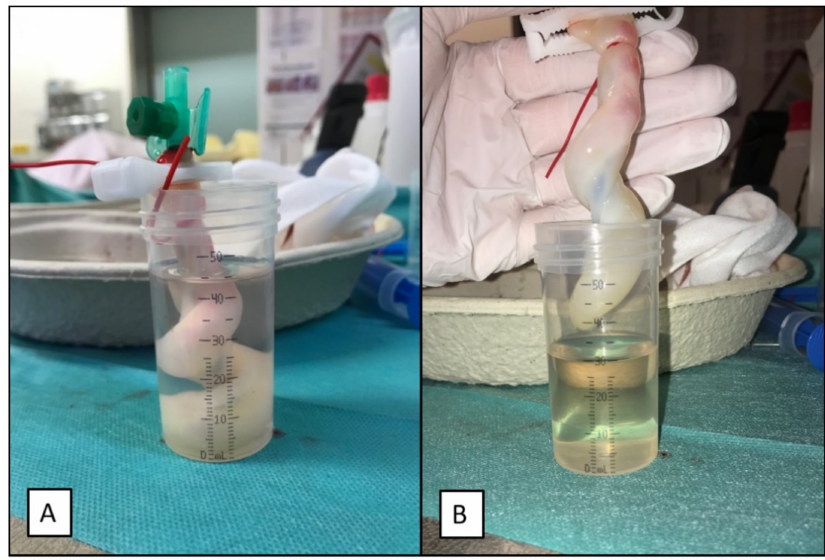
Figure 3. ( A ): The predefined fluid bolus of 0.9% saline solution was administered over one minute via the inserted and secured catheter. The free end of the umbilical cord remnant was positioned into a measuring cup, and the infused fluid was thereby collected. ( B ): To record the fluid level in the measuring cup, the umbilical cord remnant was removed and held in position to allow the fluid to drip off into the cup for another 30